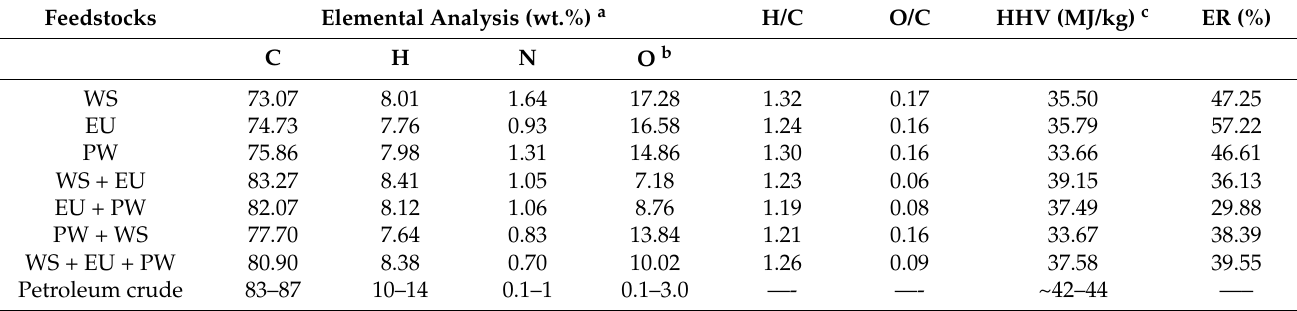
Table 3. Elemental analysis of the